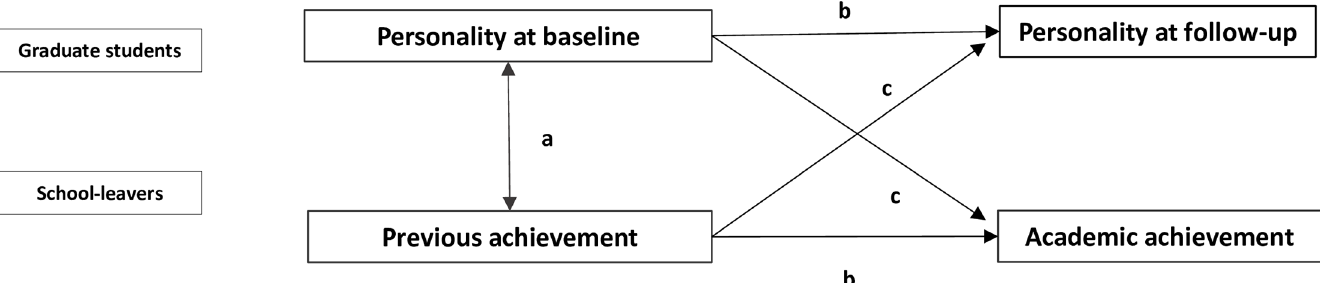
Fig 2. Conceptual model of the cross-lagged association between personality and